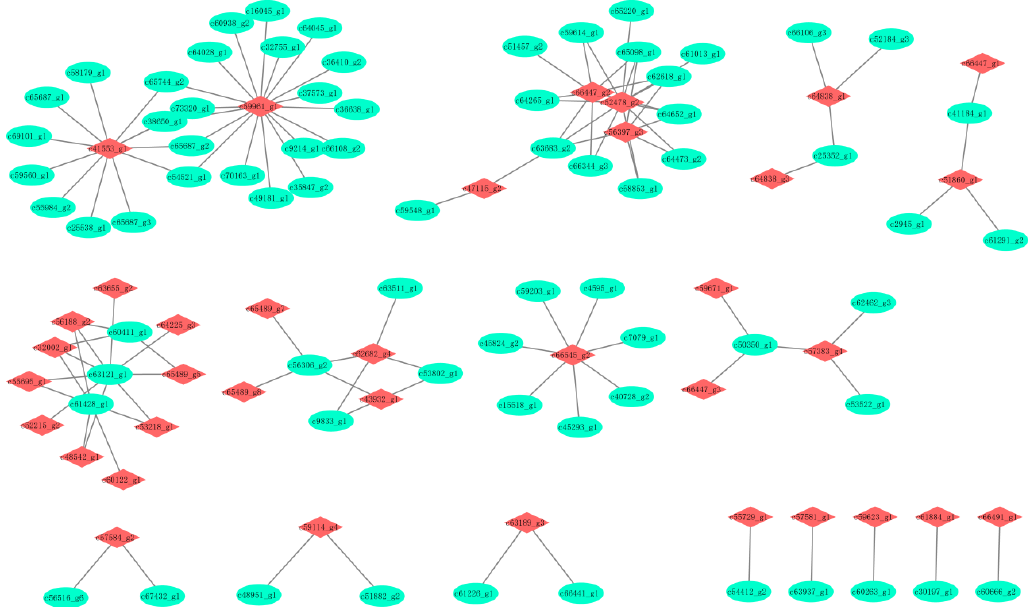
Figure 4. Gene regulation network of the hormone-related genes. Each node represents a gene and edges between the genes represent the connectivity. Red nodes represent source genes and green nodes represent target genes.